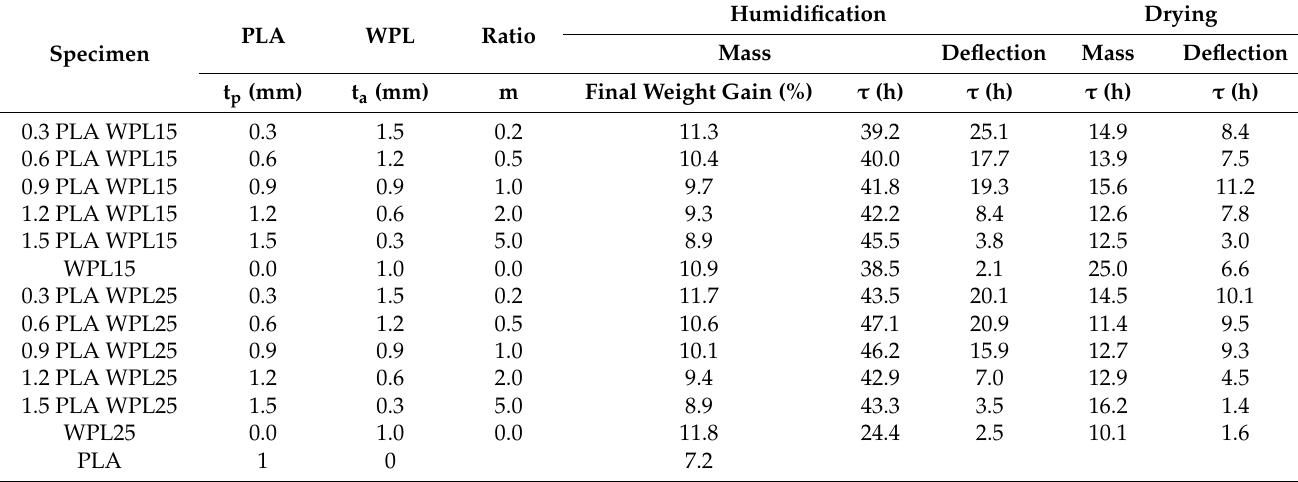
Table 3. Dynamics of weight change and shape change of tested biomaterial determined by time constant τ (tau) in First Order system (tp—thickness of passive layer, ta—thickness of active layer, m—ratio of thicknesses of active to passive